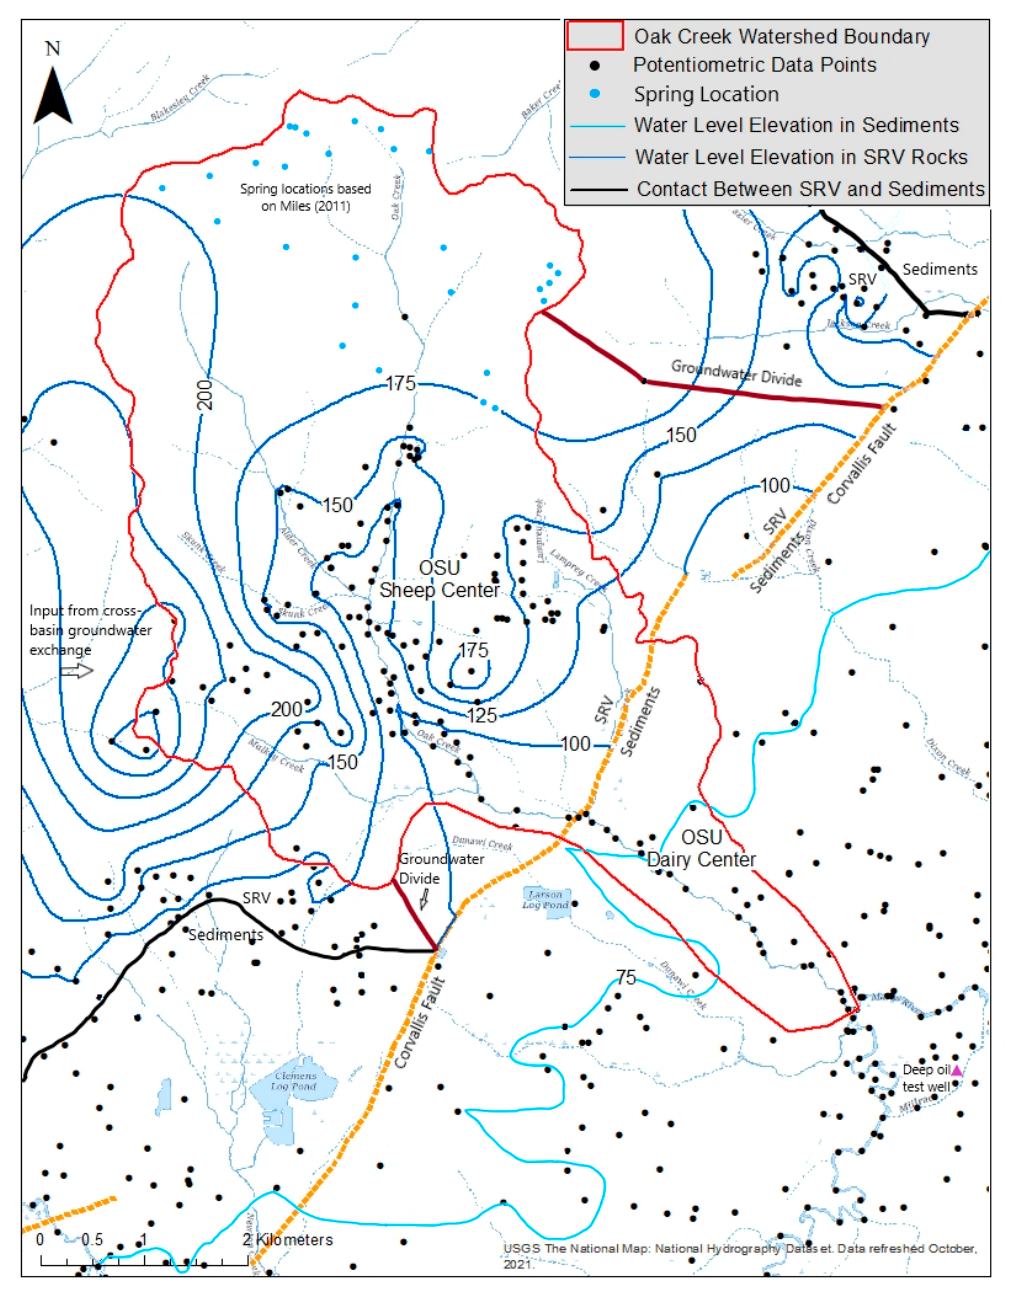
Figure 6. Potentiometric surface map of the Oak Creek Watershed and the surrounding region.